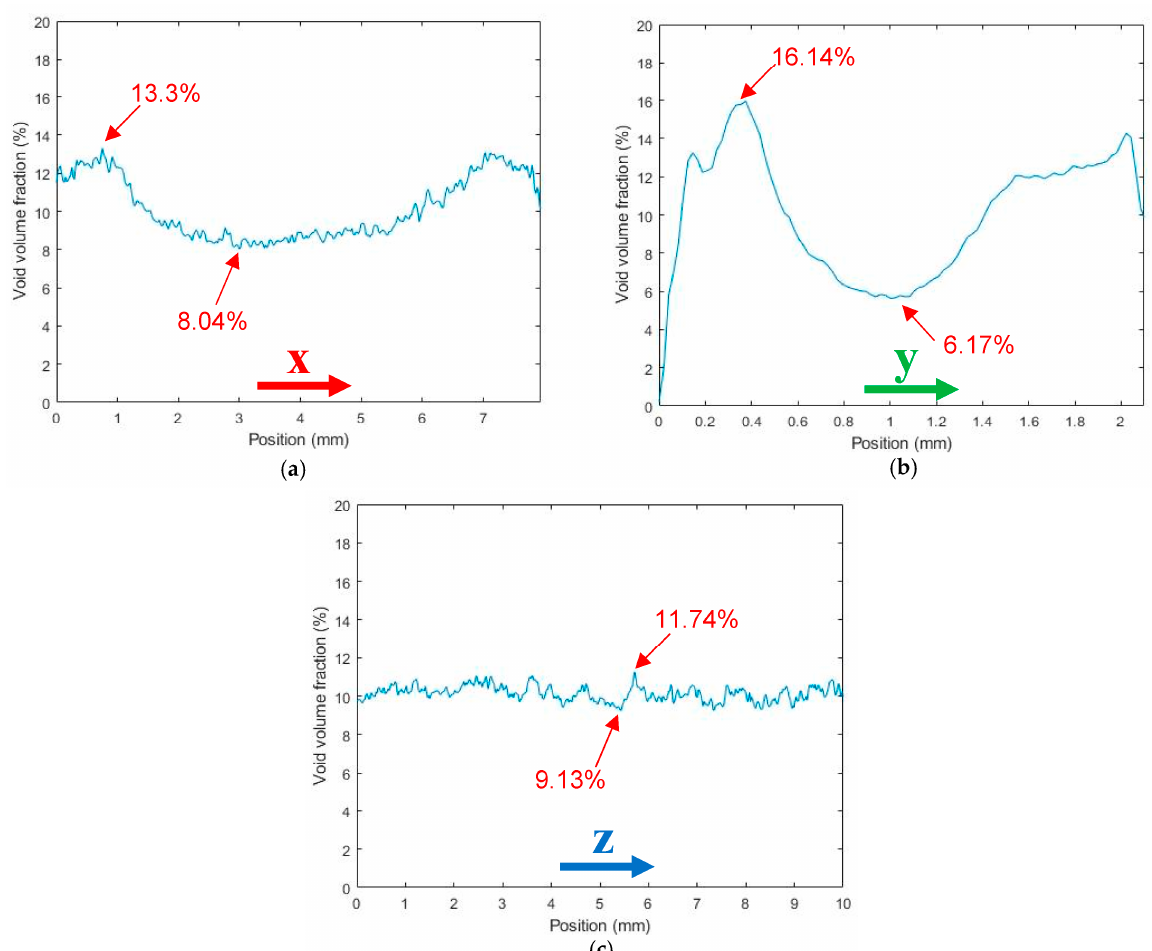
Figure 9. Void volume fraction along the coordinate directions of a SCF/ABS roller-compressed single bead: ( a ) along the X-direction; ( b ) along the Y-direction; ( c ) along the Z-direction.